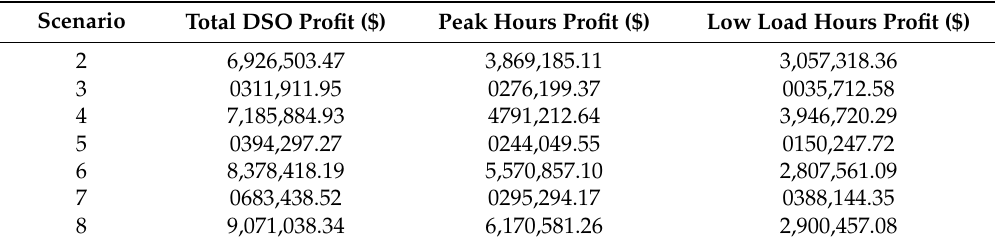
Table 10. Distribution network operators (DSO)